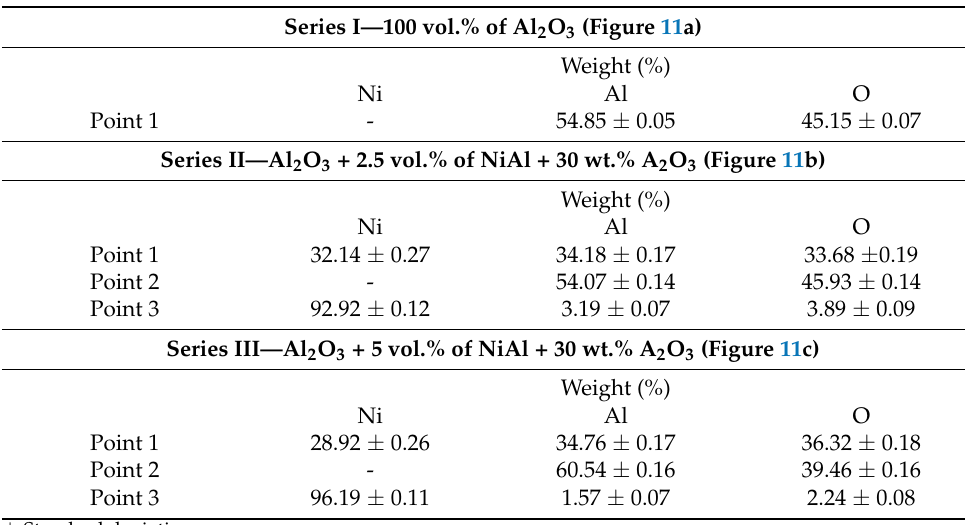
Table 3. The weight content of the samples from different